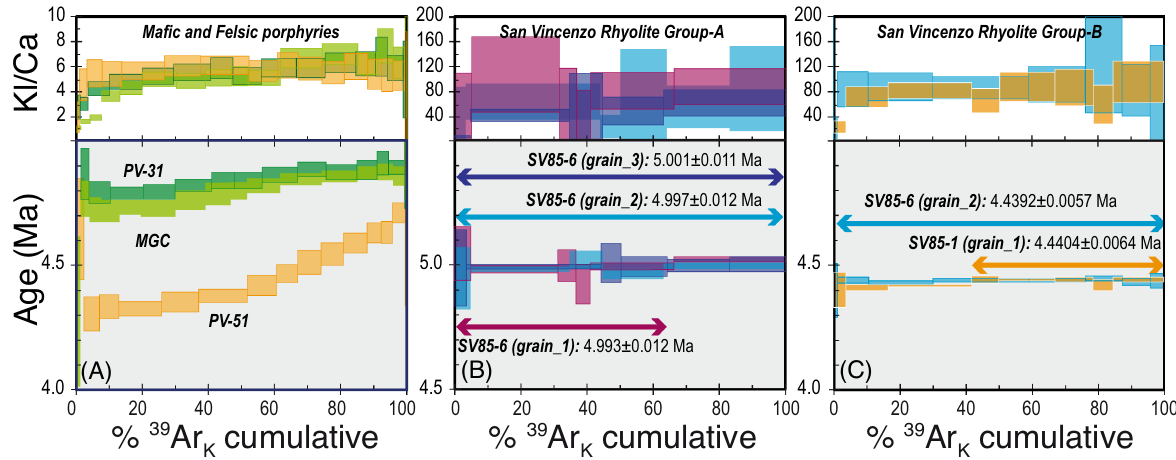
Figure 5. Age and K/Ca (derived from neutron-produced 39 Ar K / 38 Ar Ca ratio) spectra from step-heating experiments of K-feldspar separates. Box heights indicate the 2σ analytical uncertainty. ( A ) Mafic and felsic porphyries. ( B ) Sanidine from the Group-A of the San Vincenzo Rhyolite. ( C ) Sanidine from the Group-B of the San Vincenzo Rhyolite. Data for mafic and felsic porphyries were completed on ~ 10–15 mg of mineral separate, using a single-collector noble gas mass spectrometer. Data for San Vincenzo Rhyolites were completed on individual grains, using a multi-collector noble gas mass spectrometer.